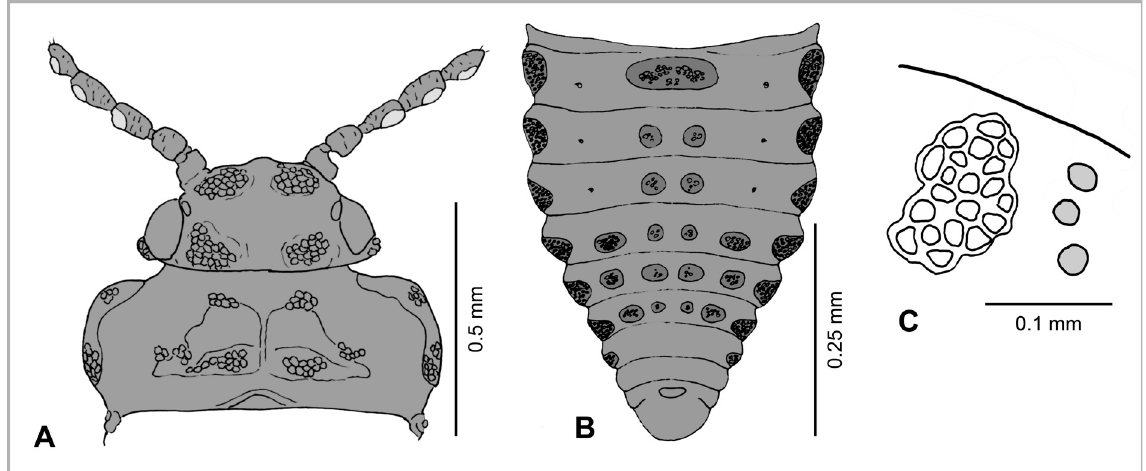
Fig. 81. Pineus (Pineus) strobi (Hartig, 1837). A . Alata, head and prothorax (after Carter 1971, modified from Heie 2004). B . Alata, abdomen (after Börner, modified from Heie 2004). C . Aptera, outer intraocular group of wax gland pits (freely after Blackman & Eastop